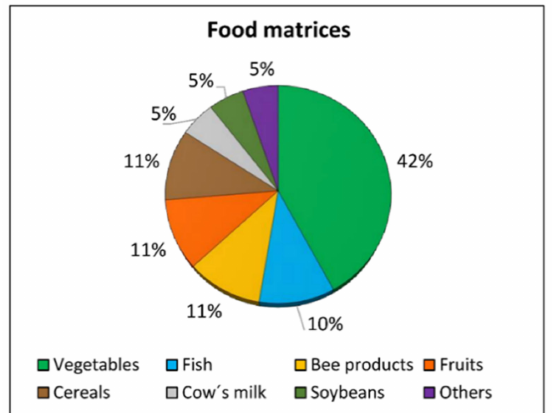
Figure 4. Food matrices according to the percentage of studies (2019–2021) that evaluated the levels of pesticide residues in them and the associated risk of exposure of the population (Source: Table